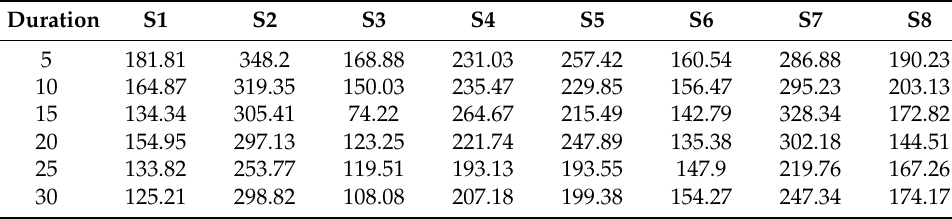
Table 5. Representation of skin conductance of the eight